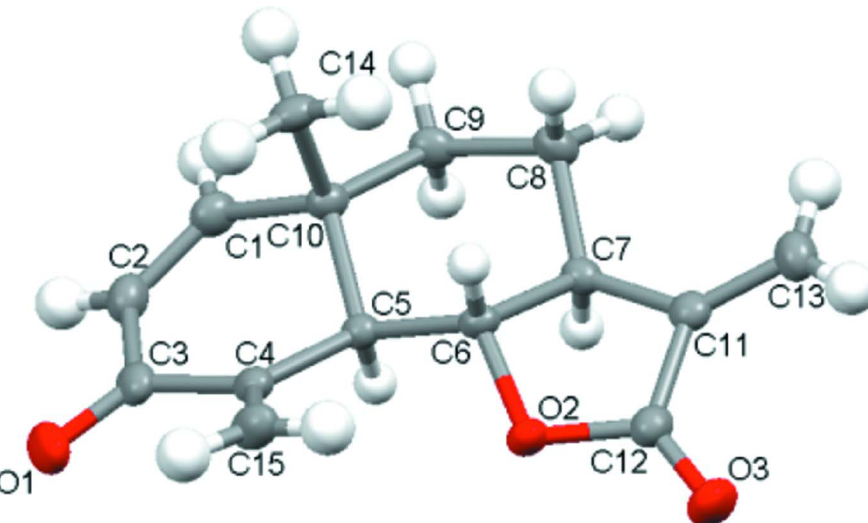
Figure 1 Molecular structure showing displacement ellipsoids at 50% probability for all atoms.